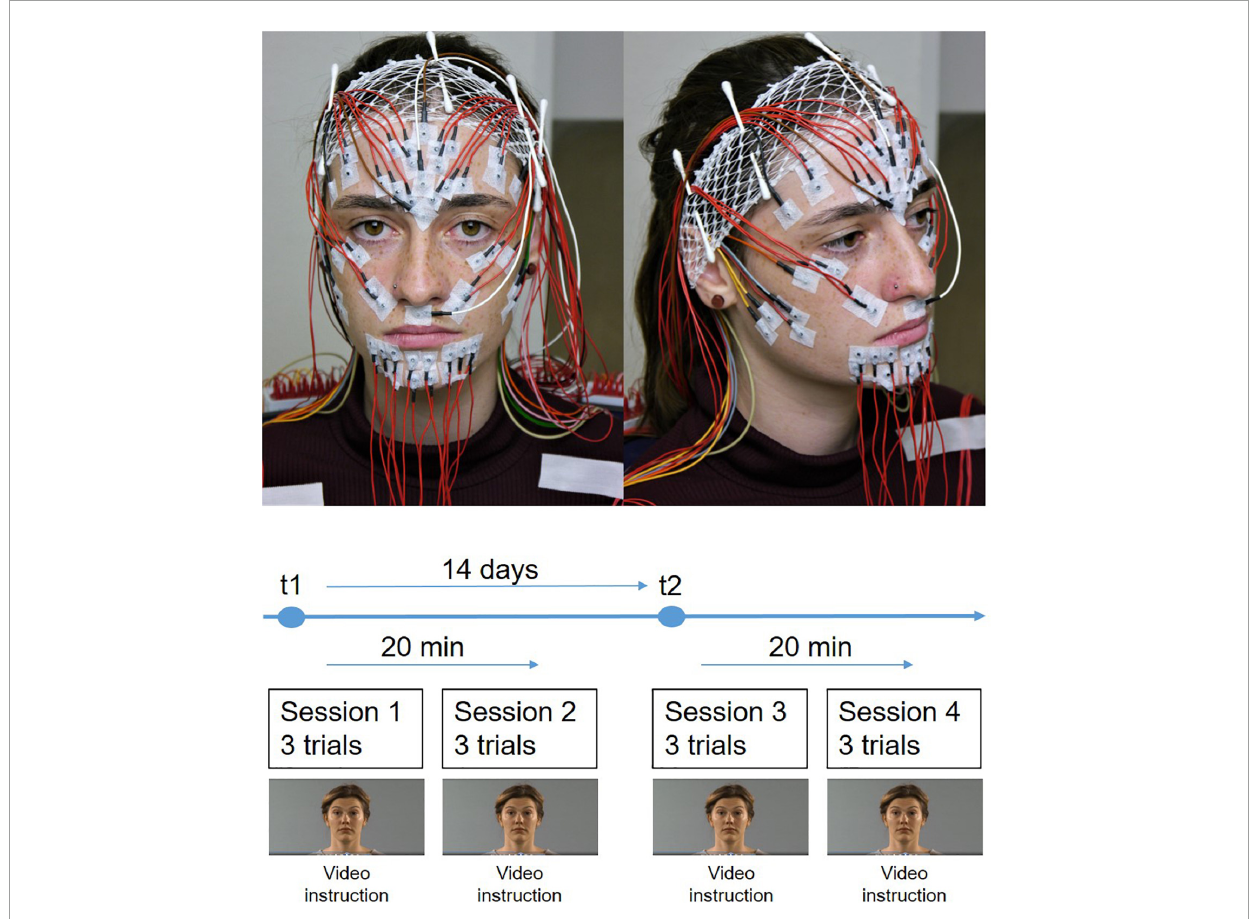
FIGURE1 The experimental setup. (Top) Simultaneous application of the EMG electrode schemes after Fridlund and Cacioppo and Kuramoto on the face of the participant. (Bottom) Time course of the measurements. The measurements were performed at two time points (t1 and t2). The interval between t1 and t2 was 14 days. Two EMG measurement sessions were performed at each time point. The interval between both sessions was 20 min. Each sessions contained three trials for each facial